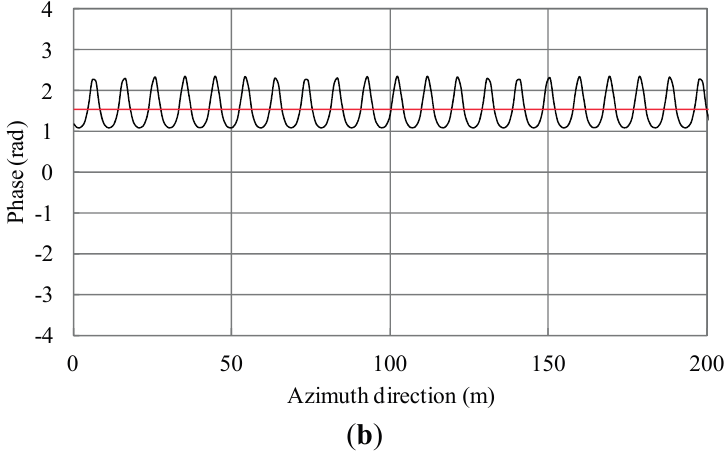
Figure 6. Simulation results of a single Bragg resonant wave with an additional current. ( a ) Phases of simulated SAR signals of master and slave antennas in the azimuth direction; ( b ) Phase difference of (a). The black line shows the phase differences. The red line shows the